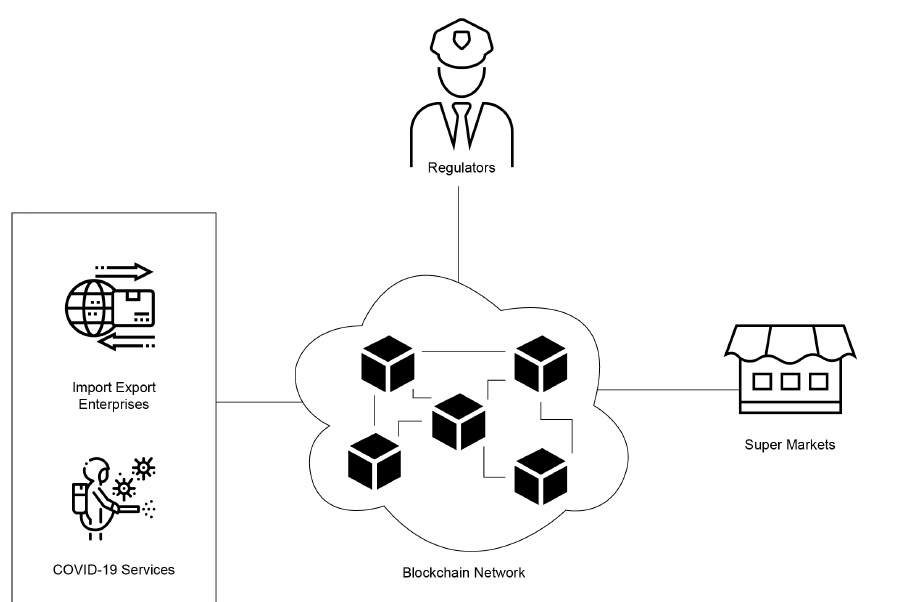
Figure 6. The logical overview of the